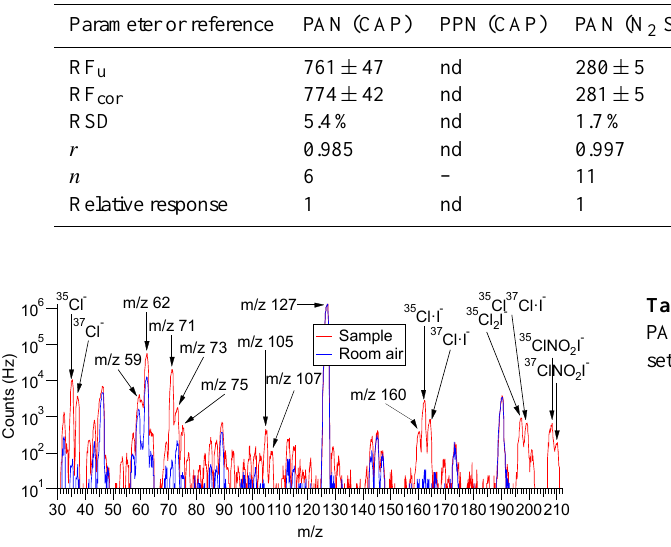
Table 3. Response factors of the PAN-GC (in mVsppbv − 1 ) in the CAP and the N 2 STD sensitivity setting, and of the TD-CIMS (in Hzpptv − 1 ) for PAN and PPN during the Abbotsford campaign. TD-CIMS counts were normalized to 1 × 10 6 reagent ion counts at m/z 127. RF u is the uncorrected response factor, RF cor is the response factor corrected for PAN impurities contributing to the 6 PN sig- nal, RSD is the relative standard deviation, r is the r value of the calibration plot, n is the number of calibration runs, and nd means not determined.